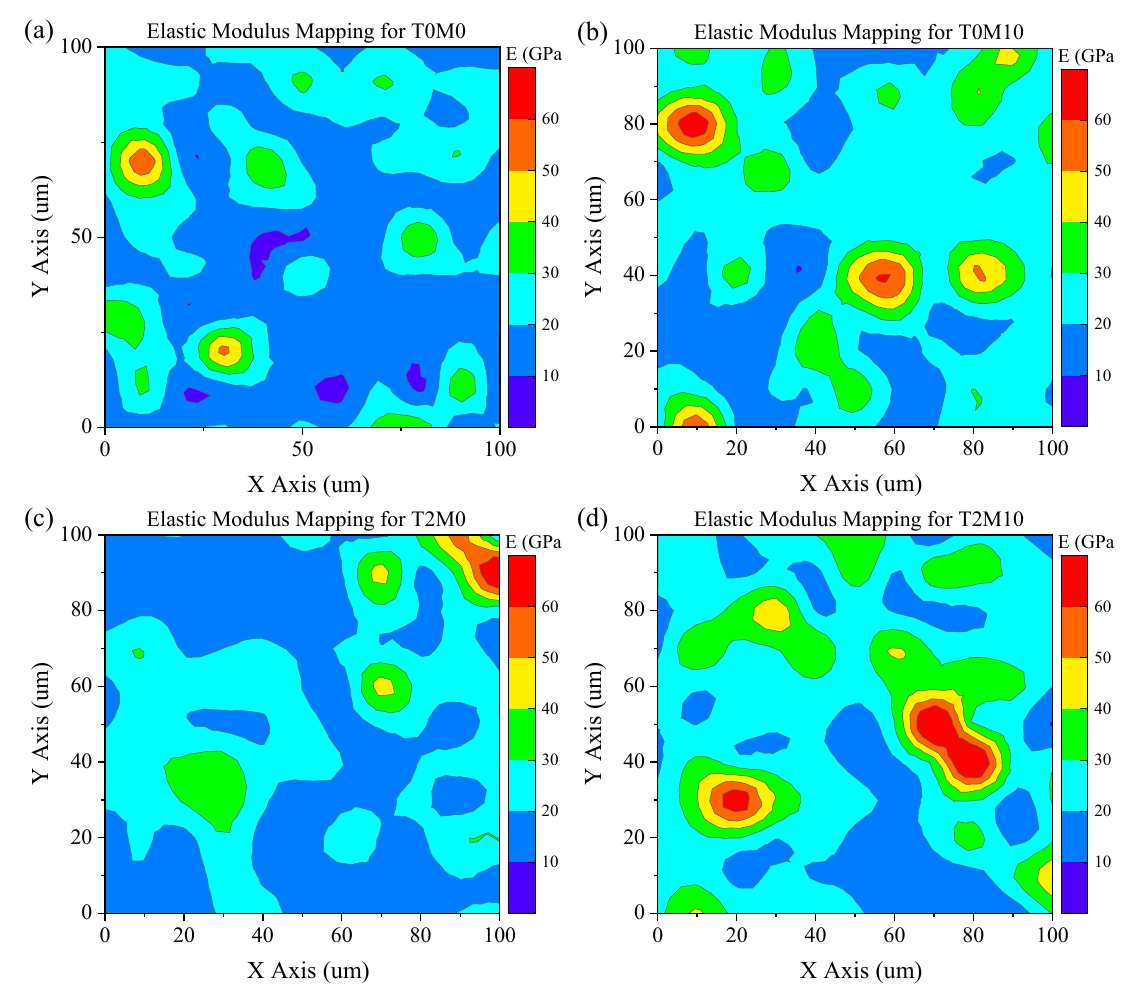
Figure 10. Contour mapping of elastic modulus obtained from grid of nanoindentation: ( a ) T0M0; ( b ) T0M10; ( c ) T2M0; ( d ) T2M10. Table 4. Elastic modulus of different phases of C–S–H from grid of nanoindentation of MK blended cement pastes with